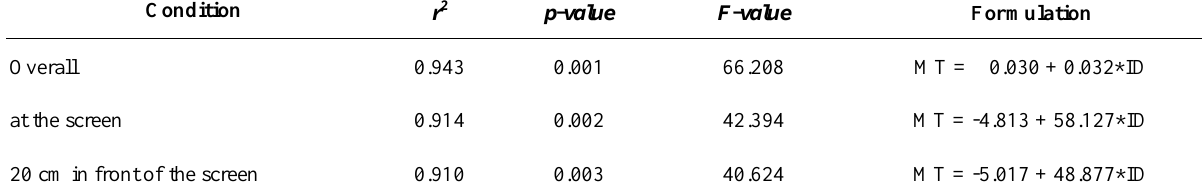
Regression results on eye gaze movement time